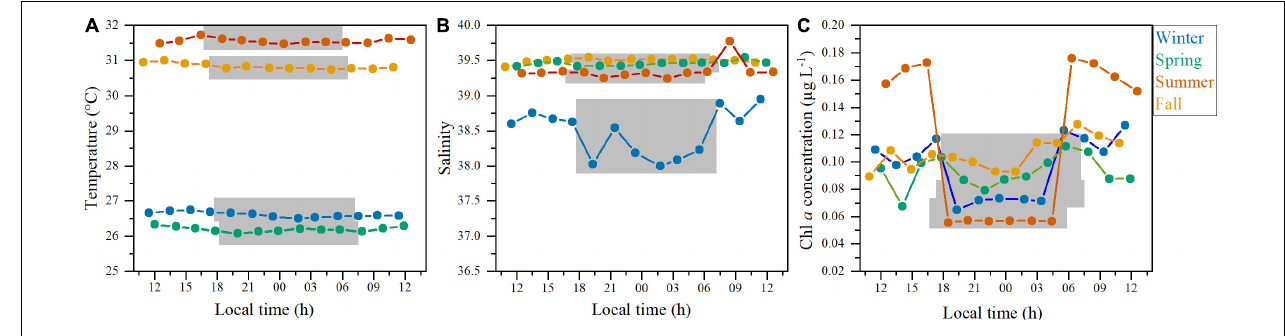
FIGURE 1 | Environmental properties measured every 2 h at the surface of the study station in the four diel cycles. (A) temperature ( ◦ C), (B) salinity, and (C) chlorophyll a concentration ( µ g L − 1 ). The gray shading represents nighttime for each sampling.